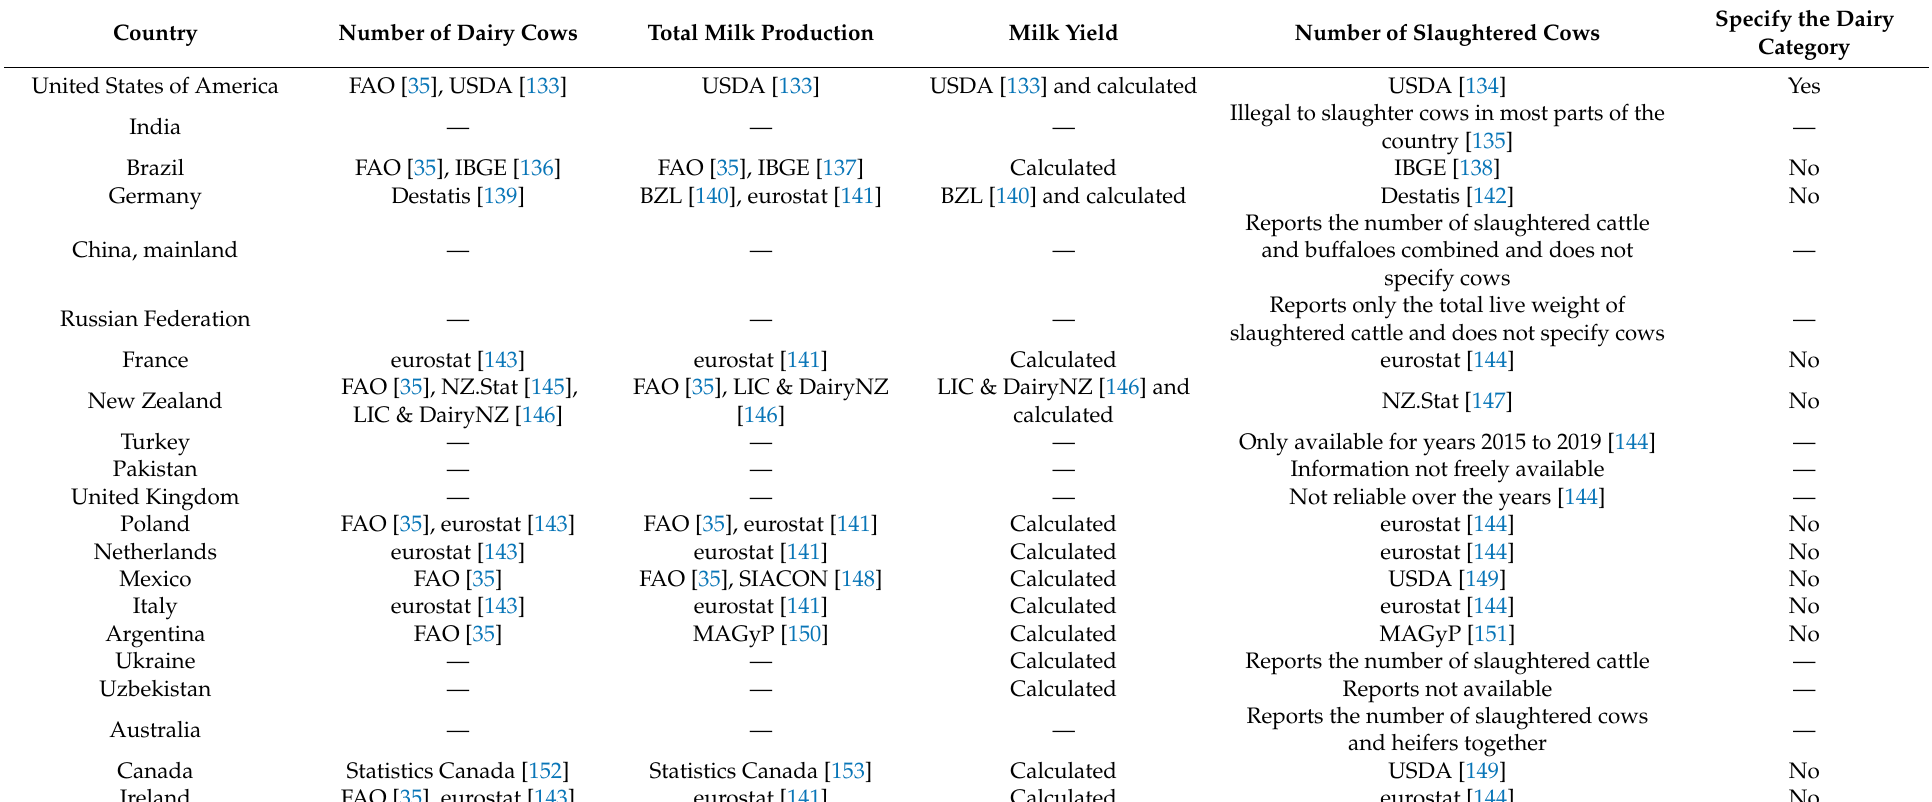
Table A1. The sources of official statistics published by the top 21 high milk-producing countries regarding the number of dairy cows, total milk production, average milk yield per animal per year, and the number of slaughtered cows as well as data availability information. Country Number of Dairy Cows Total Milk Production Milk Yield Number of Slaughtered Cows